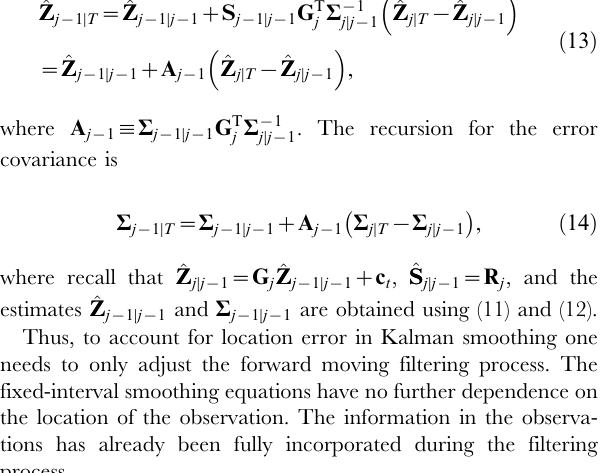
Table 1. When the measurement error variance was small (0 : 01) , there was little difference in the results for the three